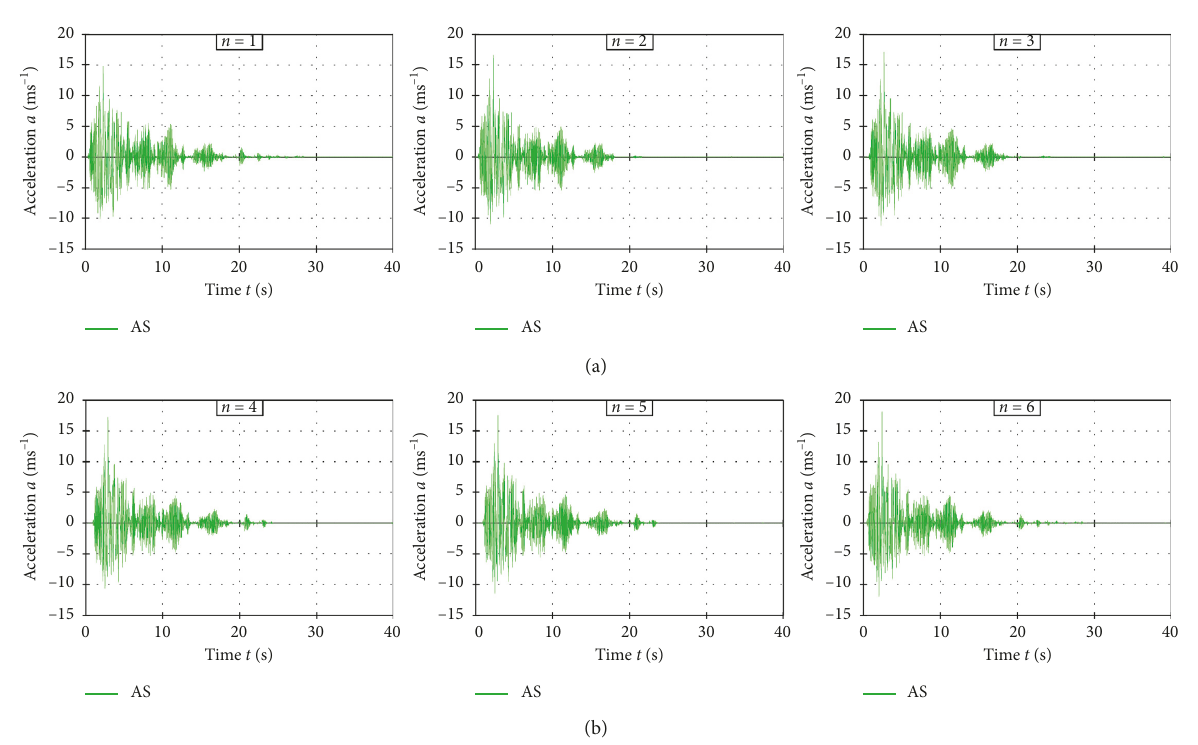
2 for repeated excitation AA.